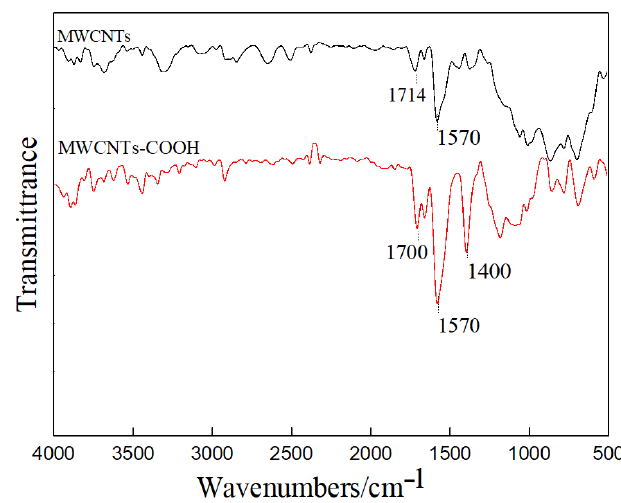
Figure 1. FT-IR spectra of MWCNTs before and after modification.